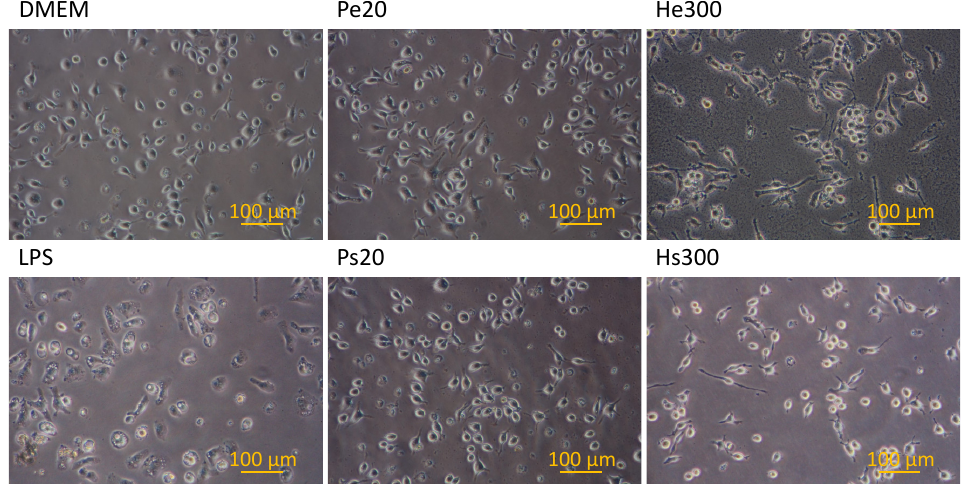
Figure 5. Morphology of macrophages after incubation with various vaccines for 24 h. DMEM: medium only; LPS: with 100 ng/mL lipopolysaccharide; Pe20: vaccine prepared using PDT with 4 µ g/mL of verteporfin at 20 J/cm 2 fluence followed by filter extrusion after 24 h of recovery time; Ps20: vaccine prepared using PDT with 4 µ g/mL of verteporfin at 20 J/cm 2 fluence, with the supernatant collected after 24 h of recovery time; He300: vaccine prepared using 300 µ M H 2 O 2 followed by filter extrusion after 24 h of recovery time; Hs300: vaccine prepared using 300 µ M H 2 O 2 , with the supernatant collected after 24 h of recovery time. Each dish contained 3 × 10 5 macrophages, and the nanovesicle vaccine made from 5.2 × 10 6 LLC